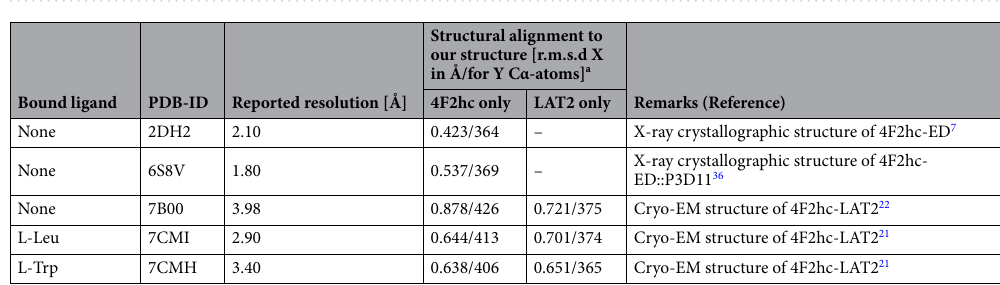
Figure 3. Overall structure of the 4F2hc-LAT2::D11vs complex. ( a ) Displayed is a vertical slice through the LAT2 structure represented as surface to highlight the large cytoplasmic cavity (red asterisk), reflecting an inward-open structure. ( b ) Representation of the cryo-EM density including the detergent micelle (transparent density). ( c ) Structural model of the complex. The magnification reflects the region of the disulfide bridge between 4F2hc (C210) and LAT2 (C154). Structural elements such as transmembrane α-helices (TM), extracellular (EL) and cytoplasmic loops (CL), and the horizontal α-helix (HH) are labeled. 4F2hc, LAT2 and D11vs are colored in green, orange and violet, respectively. Dotted lines represent the membrane boundaries facing the extracellular (OUT) and cytoplasmic (IN) environments. All volume and structural representations were prepared using UCSF ChimeraX (version 1.3) and PyMol (version v2.5.2; The PyMol Molecular Graphics System, Schrödinger), see Materials and Methods. The figure was assembled and labeled using Adobe Illustrator 26.5 (https:// adobe. com/ produ cts/ illus trator).